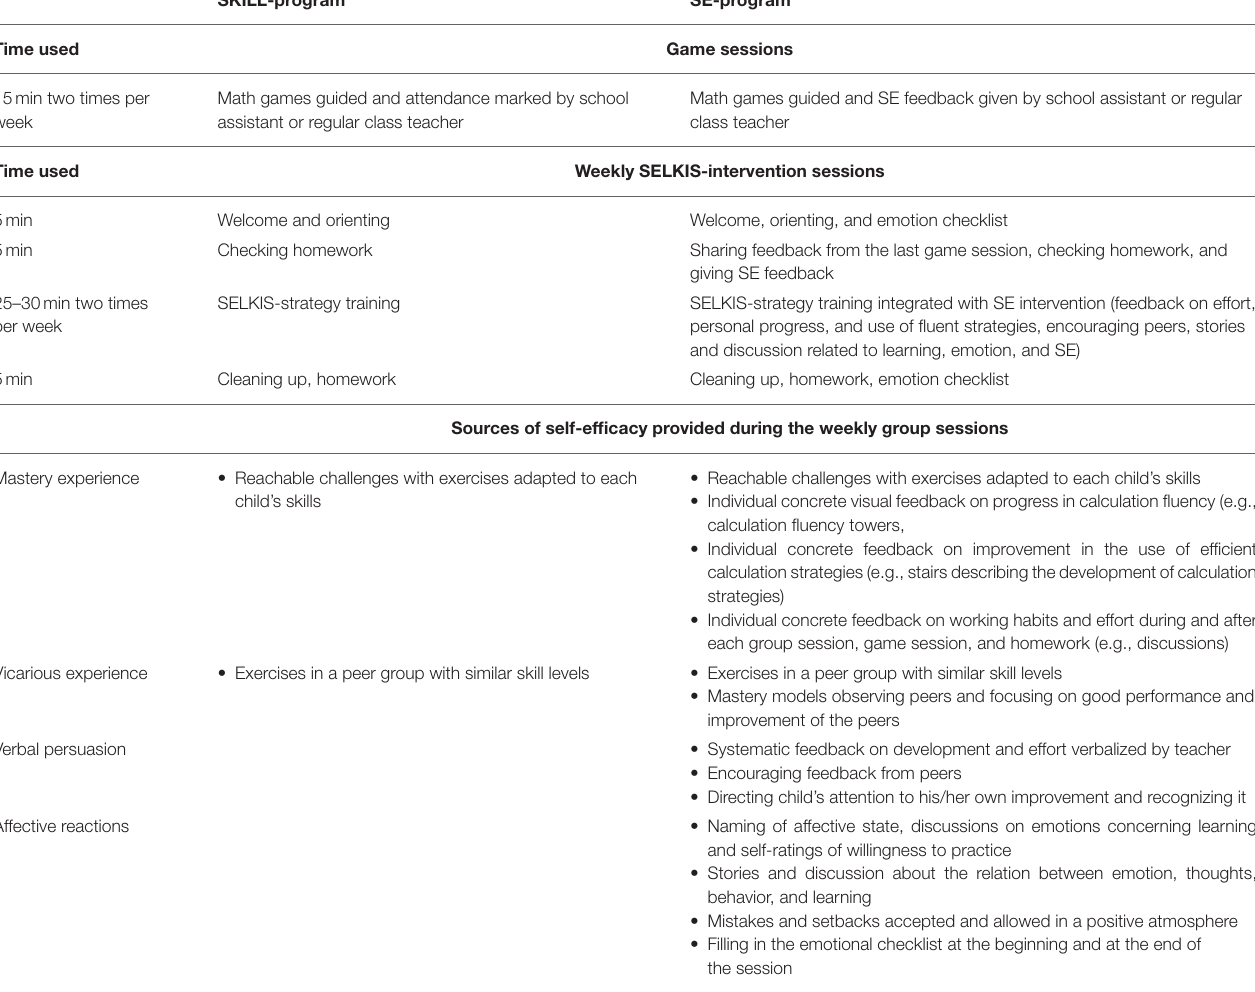
TABLE 1 | Intervention structure: Weekly SELKIS-intervention sessions and game sessions and elements of the SE-program to foster self-efficacy.